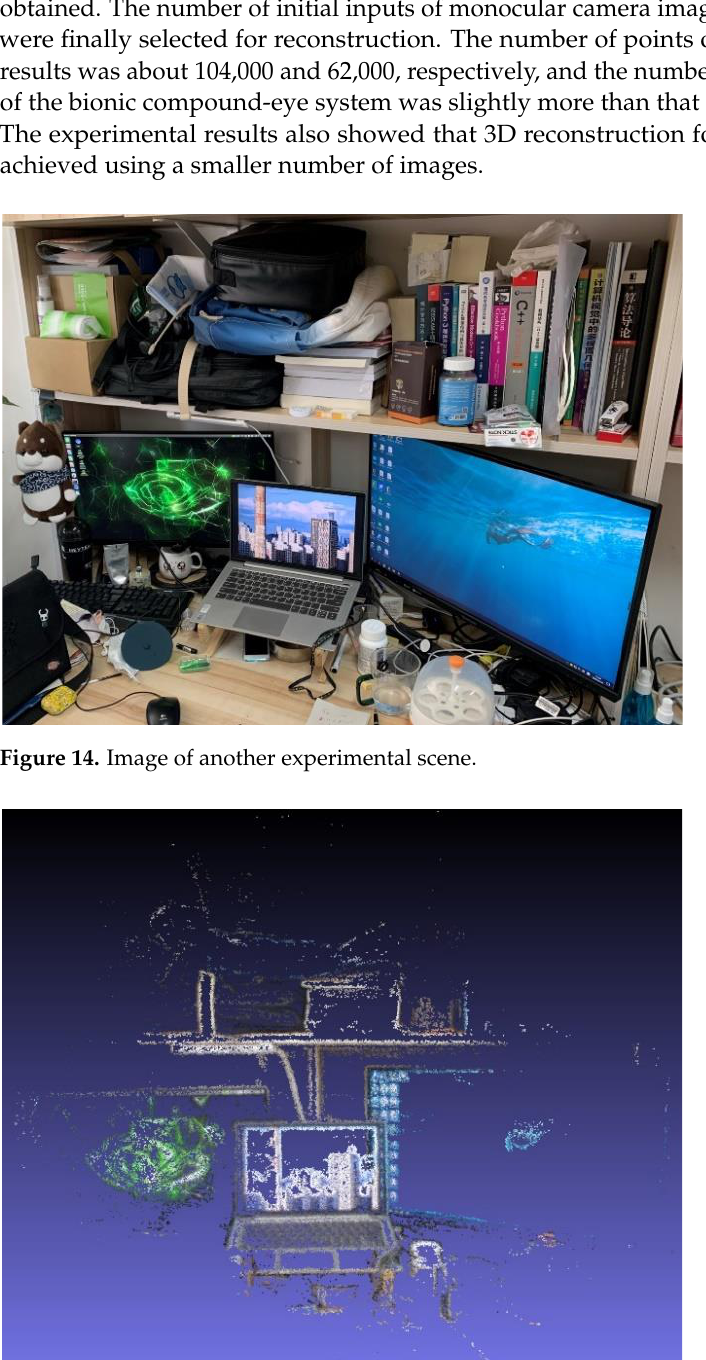
12 of 22 Figure 13. Three-dimensional reconstruction results of images shot by a monocular camera. For the images captured by the bionic compound-eye system, the relative positions of the sub-eye lenses of the system were fixed, and all images obtained by shooting five times could be successfully matched and reconstructed. For the images captured by the monocular camera, some images failed to match with other images, so the reconstruction